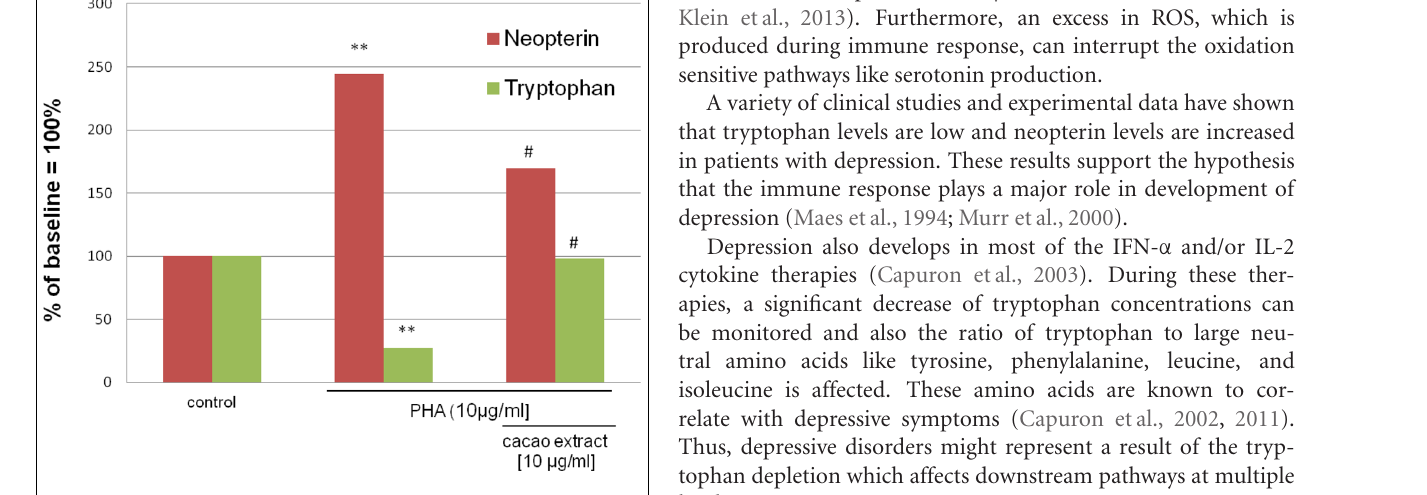
FIGURE 3 | Mean neopterin and tryptophan concentrations in mitogen (PHA)-stimulated freshly isolated peripheral blood mononuclear cells (PBMCs), either treated with 10 μ g/ml aqueous cacao extracts or left untreated, compared to unstimulated controls. The results are shown in % of the baseline in the supernatants of unstimulated PBMC. Experiments were run in duplicates and in four independent approaches [** p < 0.05 compared to unstimulated cells; # p < 0.05 compared to stimulated cells; adapted from Jenny etal.